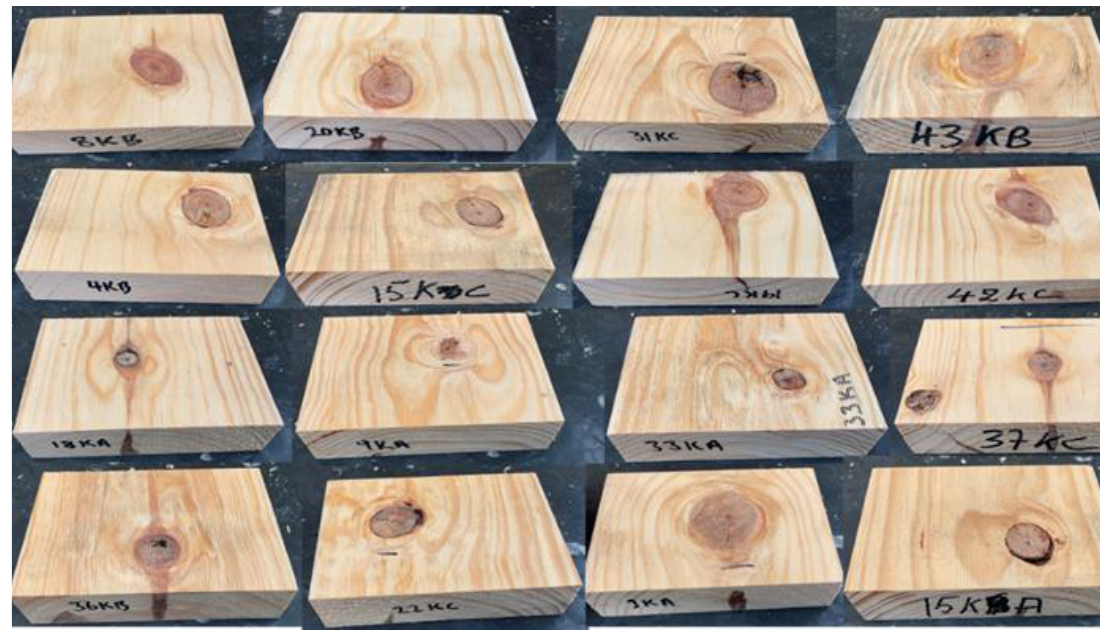
Figure 3. Examples of sound centred knots in samples.